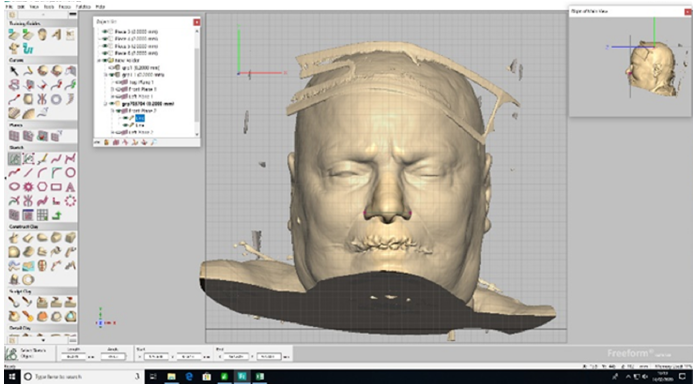
Figure 2. Distance between of the most lateral points of the nasal alae.